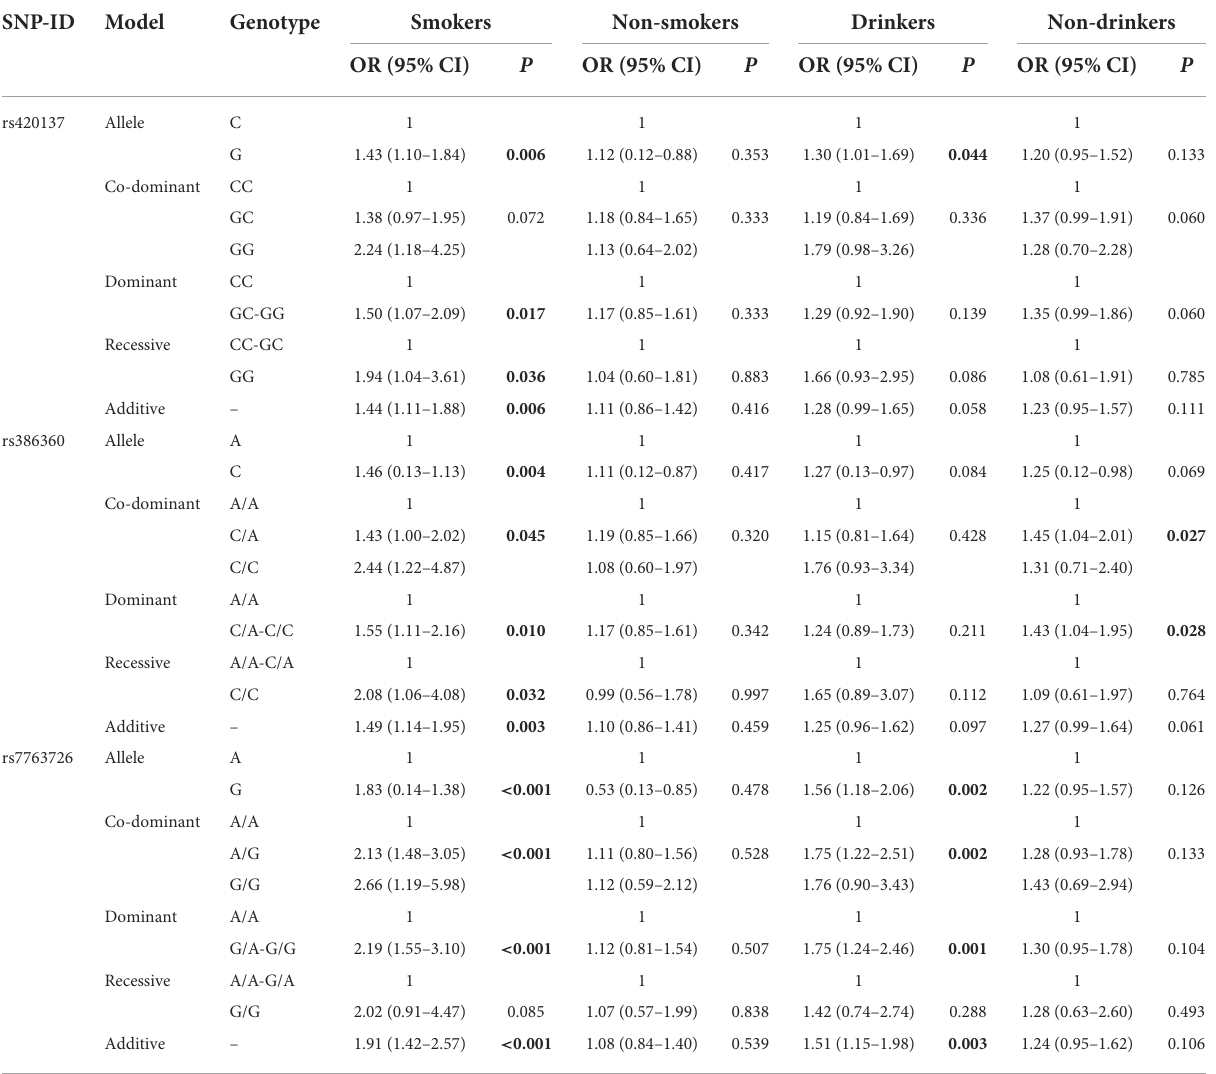
TABLE 5 FNDC1 SNPs associated with CHD risk stratified by smoking and drinking